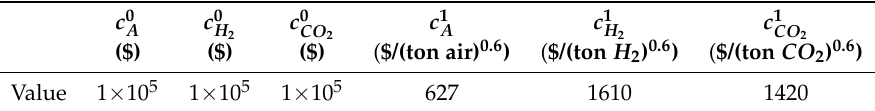
Table 5. Coefficients of capital costs for storage